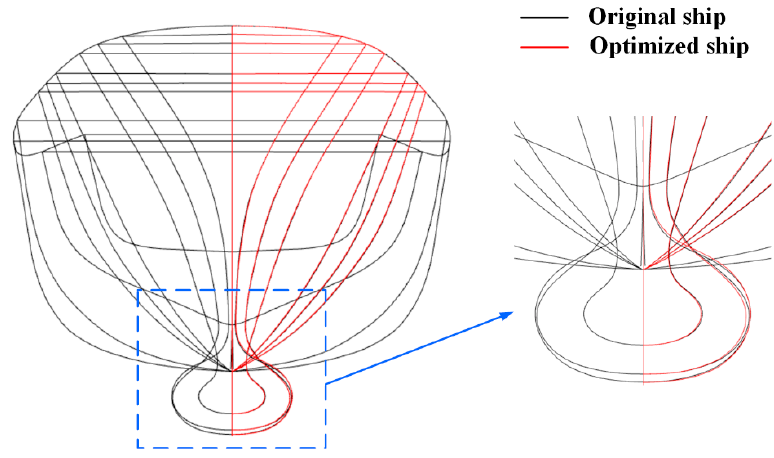
Figure 13. The body plan of the original and optimized ship models.